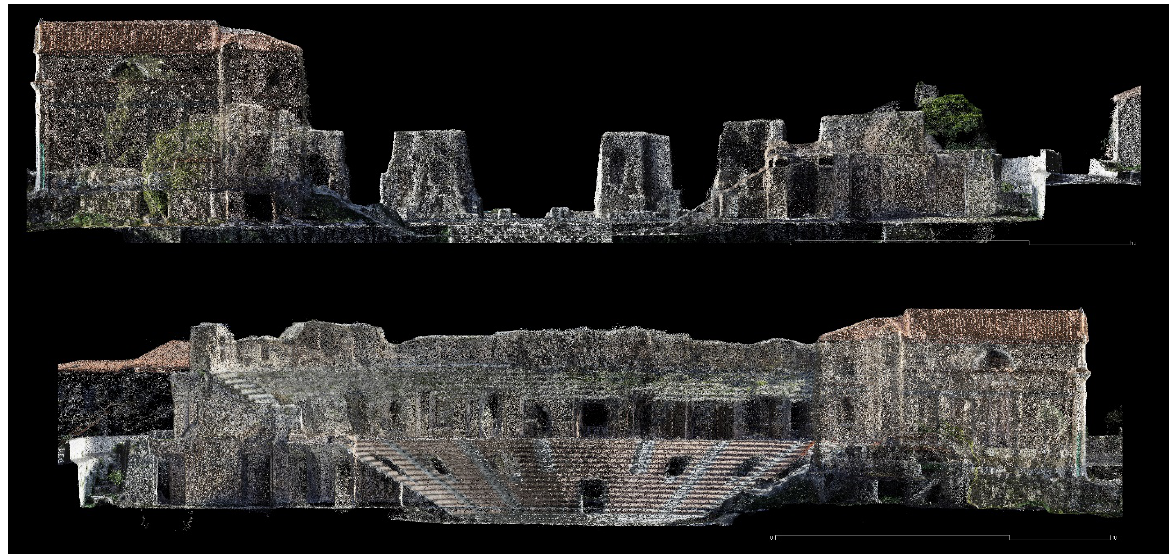
Figur e 6: Orthophotos from the point cloud. Sections towards the scaenae frons and towards the cavea.